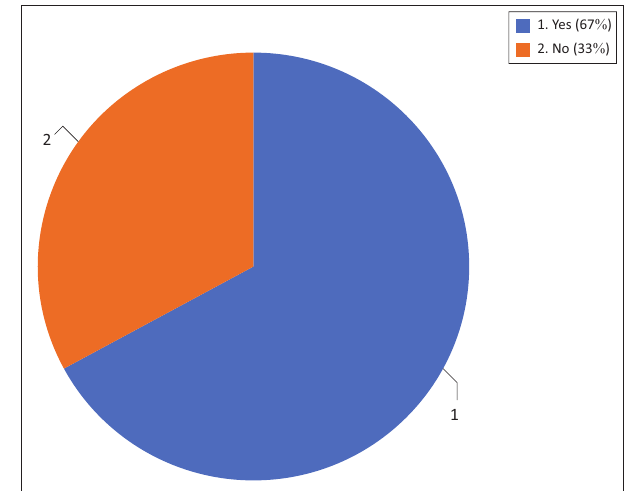
FIGURE 4: Willingness to start a business in the absence of grant TABLE 2: Analysis of variance test on risk taking versus starting a business in the absence of social grant income. Variable